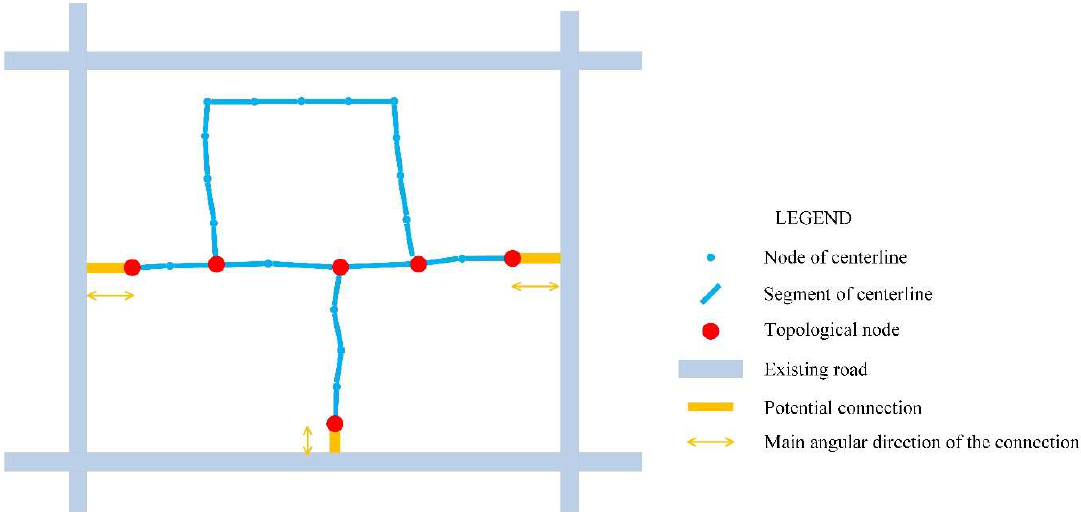
Figure 7. An illustrative example of the connections between missing and existing roads.